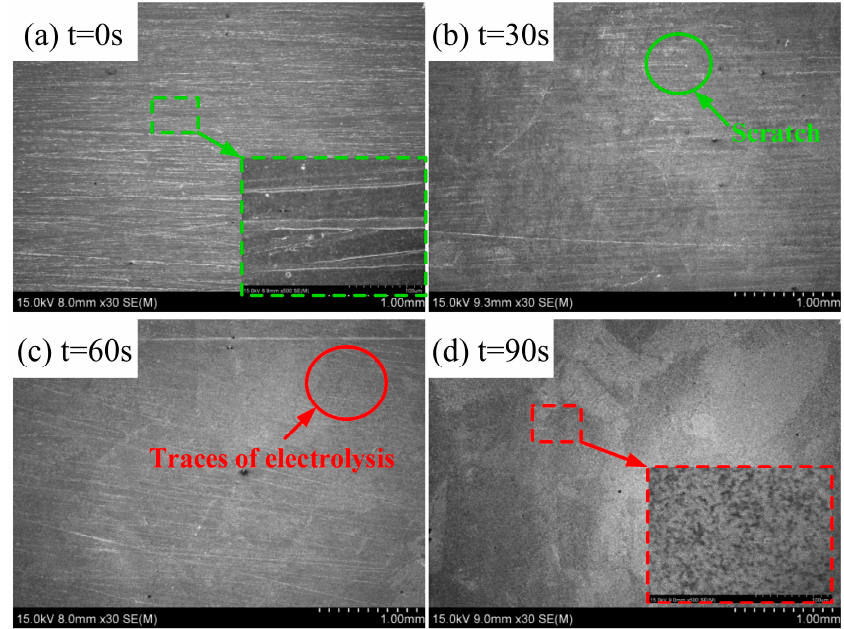
Figure 14. Material removal mechanism of ECFAP in region II (U = 6 V). ( a ) t = 0 s; ( b ) t = 30 s; ( c ) t = 60 s; ( a ) t = 90 s. ( c ) t = 60 s; ( d ) t = 90